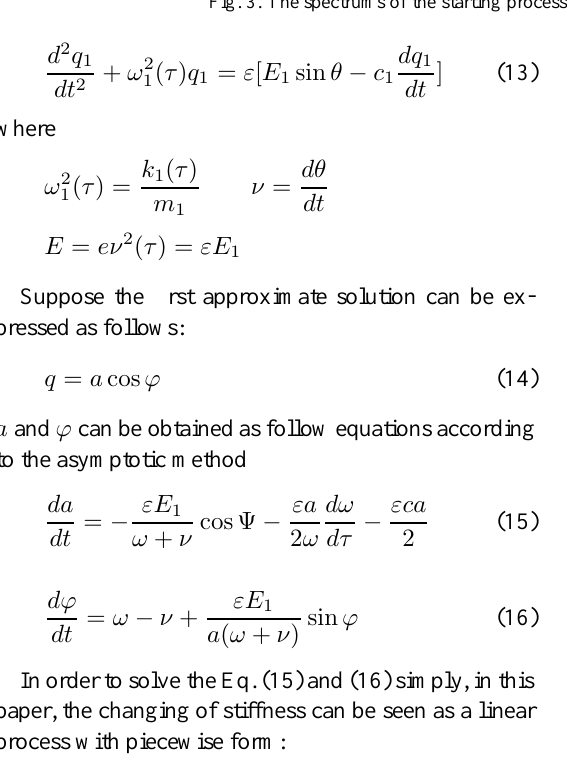
Fig. 3. The spectrums of the starting process with different changing stiffness